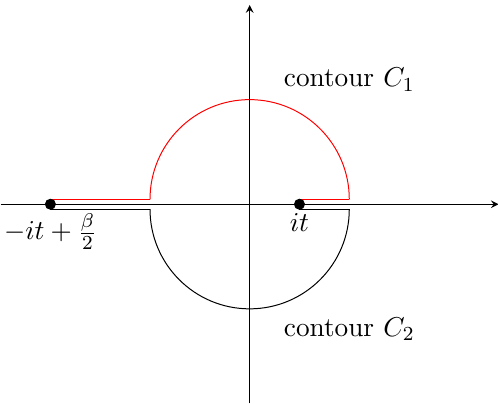
Figure 3 . The time contour involved in the entanglement entropy calculation. This (cid:12)gure is plotted in complex plane z = exp( i 2 (cid:25) t C ), where t C = (cid:28) + it is the complex time variable. The red part (cid:12) represents the h TFD( t ) j in (cid:12)gure 2, and the black represents the j TFD( t ) i . For later convenience, we name them as C 1 and C 2